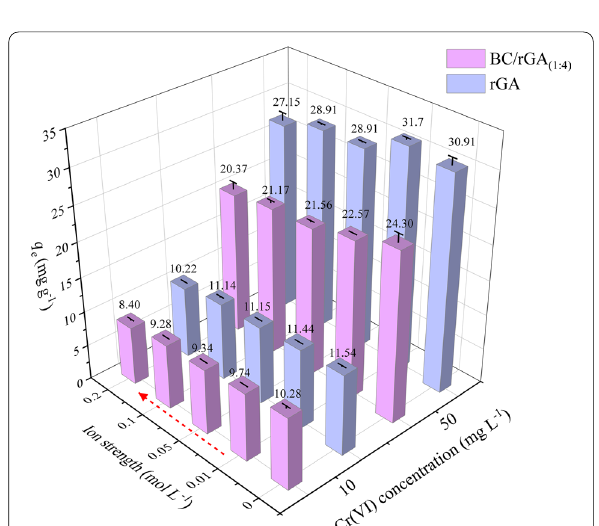
Fig. 7 Effect of background ion strength on Cr(VI)